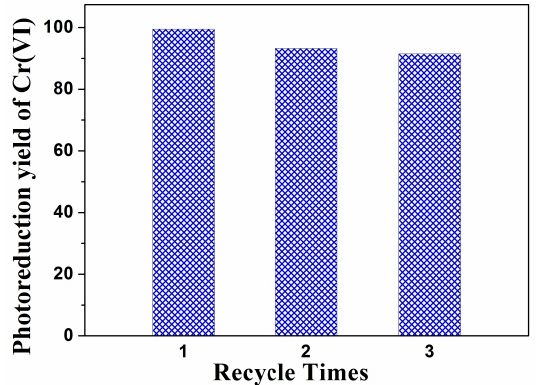
Figure 11. Recycling runs of RCP-AG(15).